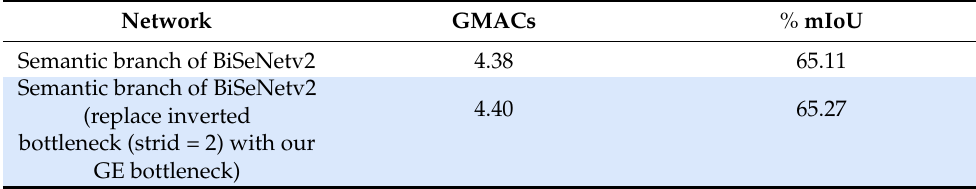
Table 3. Performance of gather-and expansion bottleneck.